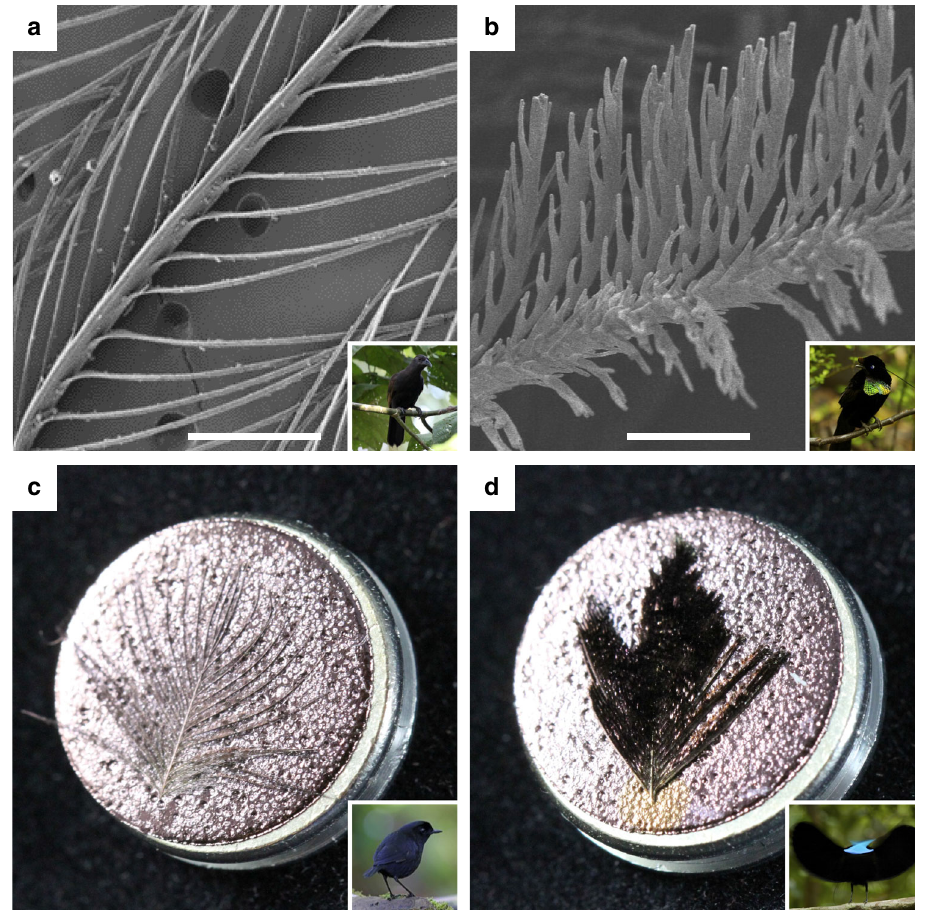
Fig. 3 Examples of normal and super black feather microstructure. a SEM micrograph of Lycocorax pyrrhopterus normal black feather with typical barbule morphology; scale bar, 200 µ m. b SEM micrograph of Parotia wahnesi super black feather with modi fi ed barbule arrays; scale bar, 50 µ m. c Gold sputter- coated normal black breast feather of Melampitta lugubris appears gold. d Gold sputter-coated super black breast feather of Ptiloris paradiseus retains a black appearance indicating structural absorption. SEM stubs are 12.8 mm in diameter. See Fig. 1 for inset photo